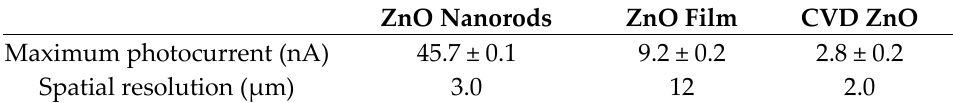
Figure 2. SEM images of (A) ZnO nanorods, (B) solution made ZnO film (inset cross-sectional view (scale bar 1 µm)) and (C) CVD ZnO, ( D – F ) the corresponding LAPS images with a PMMA dot (indicated), ( G – I ) the corresponding first derivatives of photocurrent line scans across the edge of the PMMA dots. Table 1. Maximum photocurrent and spatial resolution of ZnO in different